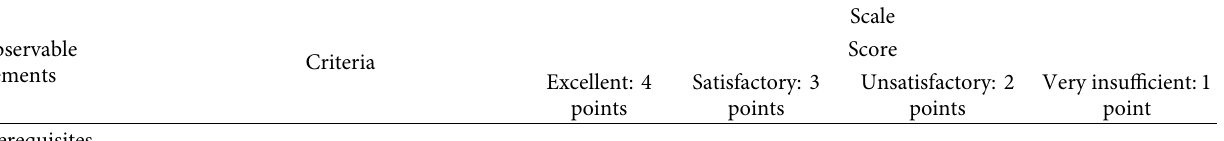
Table 1: Endodontic access cavity evaluation grid.